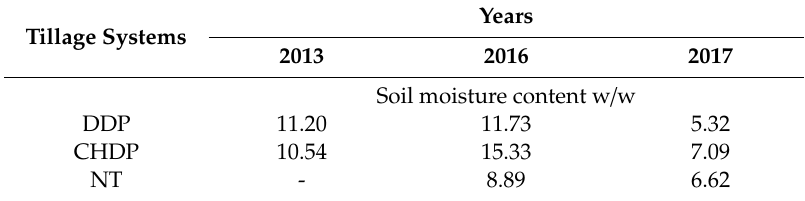
Table 1. Average soil moisture content in the soil profile (30 cm) at the experimental plots.